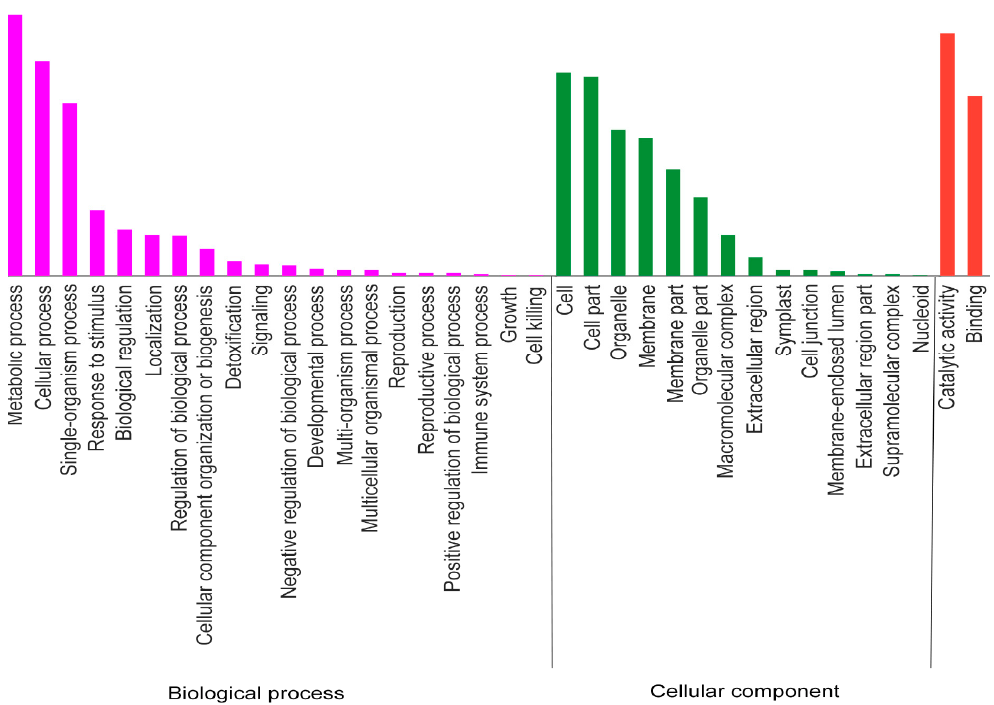
Figure 4. The Gene Ontology (GO) functional annotation of DEPs.